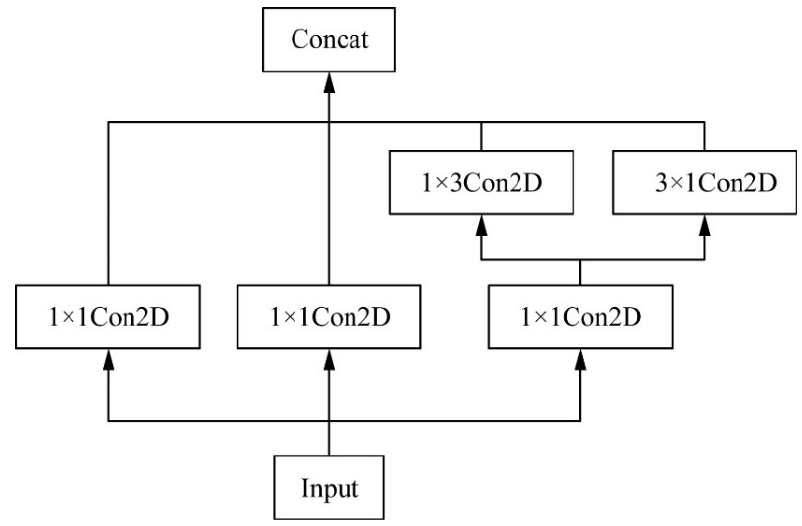
Figure 10. Inception 3 × 3 structure figure.